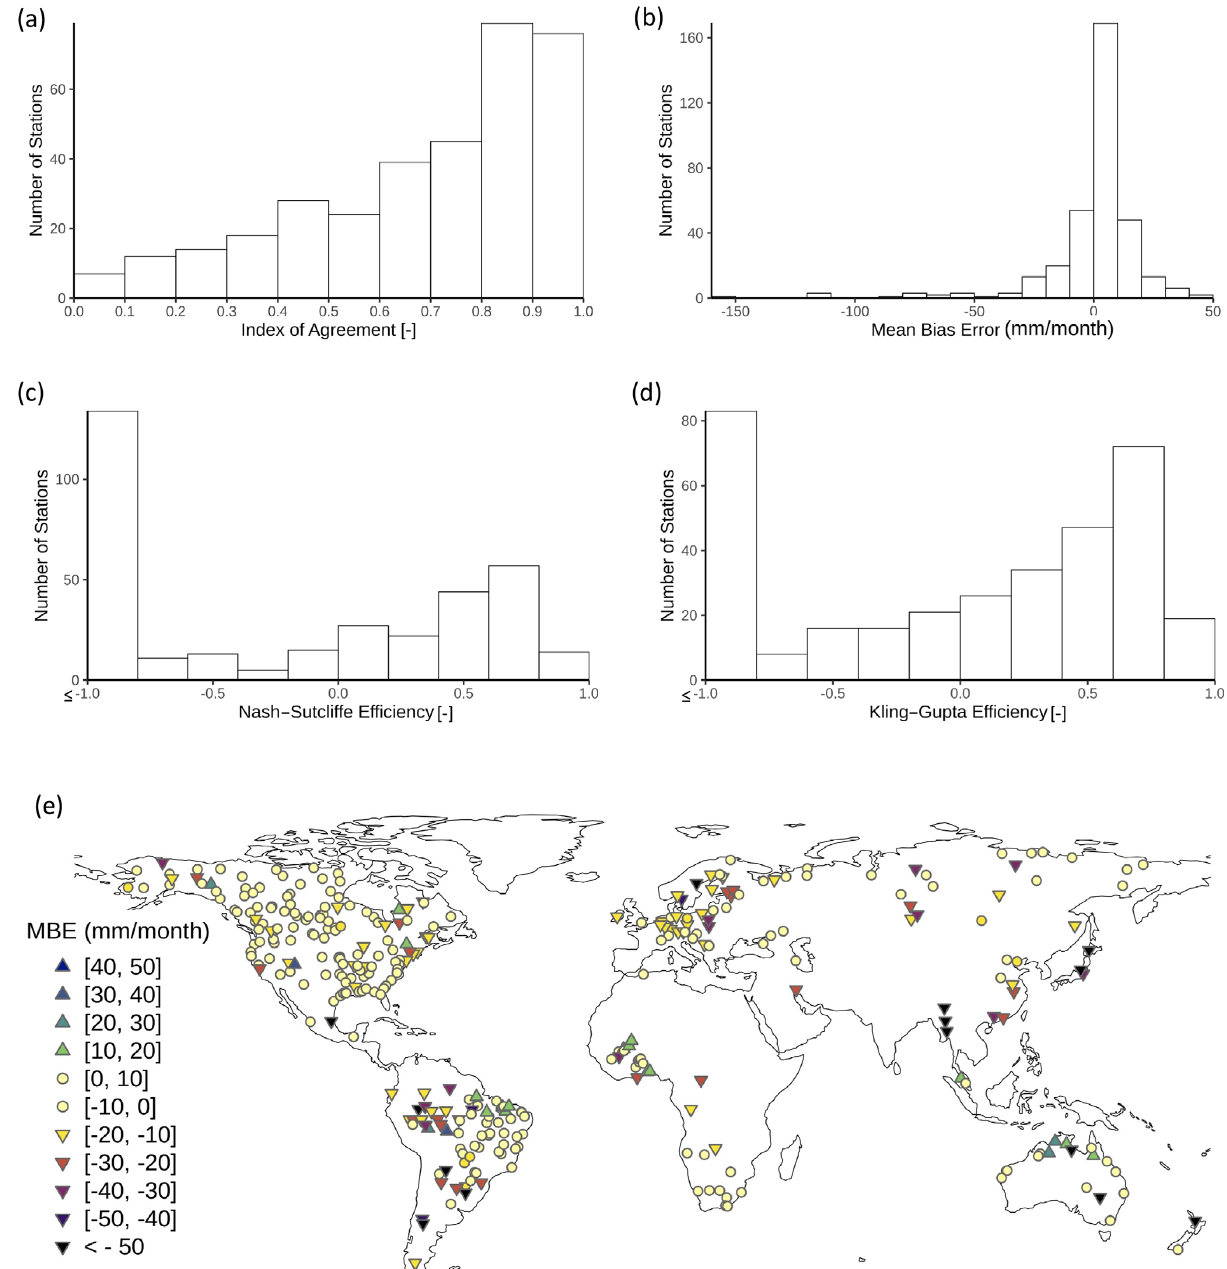
Figure 5. Frequency distribution of the index of agreement (a) the mean bias error (b) , the Nash–Sutcliffe efficiency (c) , and the Kling–Gupta efficiency (d) for monthly average discharge. Panel (e) shows a map of mean bias error in monthly discharge [mm per month], illustrating the spatial variation in bias. The average index of agreement is 0.69, and average mean bias error is − 0 . 14mm per